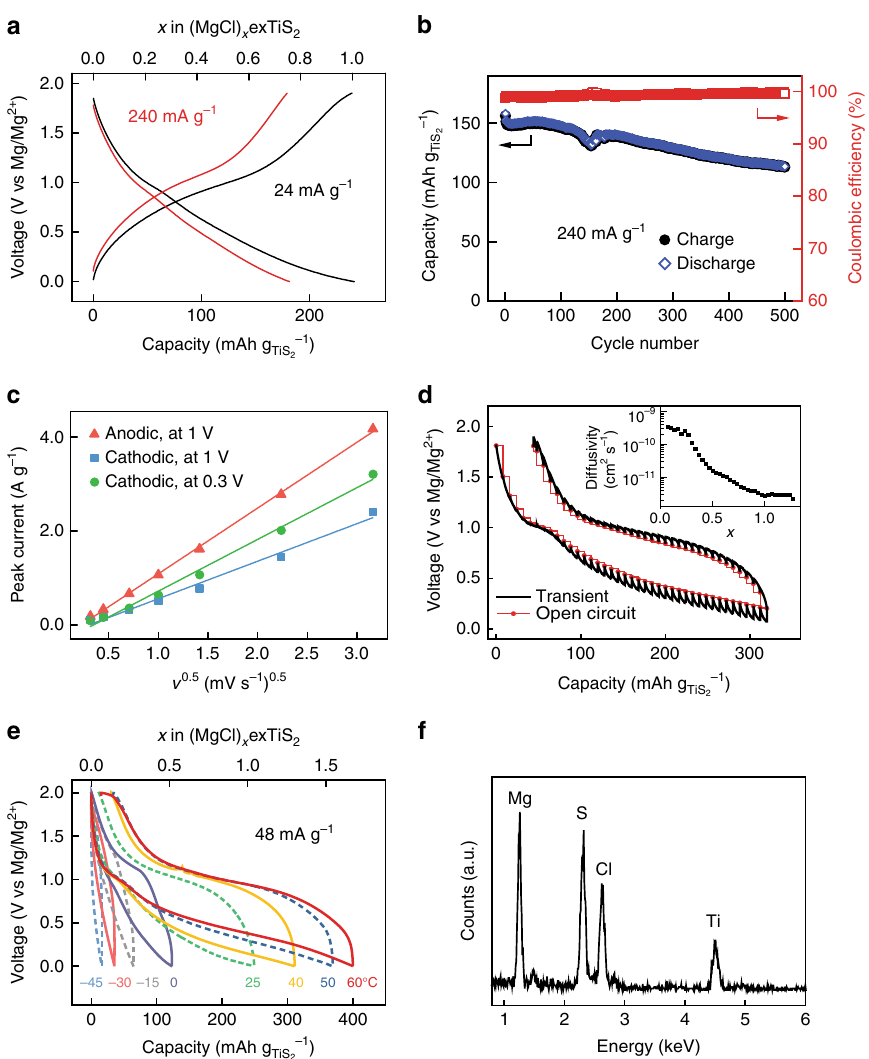
Fig. 5 Electrochemical performances of exTiS 2 . a Galvanostatic voltage pro fi les of the exTiS 2 electrode at 24 and 240 mA g − 1 at 25 °C. The number of MgCl + intercalation per exTiS 2 is also shown in the top axis. b Cycling performance at 1C-rate (i.e., 240 mA g − 1 ). The capacity dip at the 150th cycle is due to temperature change caused by temporary failure of air conditioner. c A linear relationship between the peak current in the cyclic voltammogram and the square root of the scan rate ( v ). d GITT curve of an exTiS 2 electrode. e Voltage pro fi les of exTiS 2 electrodes at temperatures varied from − 45 to 60 °C